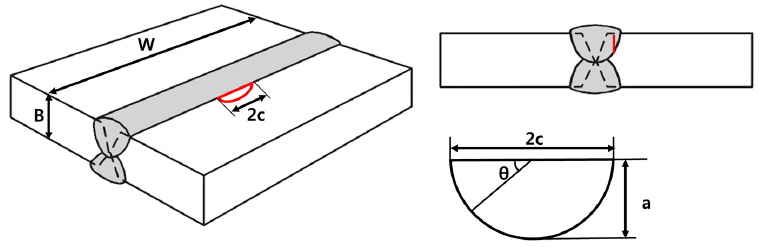
Figure 12. Schematic illustration of the wide plate with a surface crack. Table 5. Initial surface flaw size of the welded plate assumed in this study.